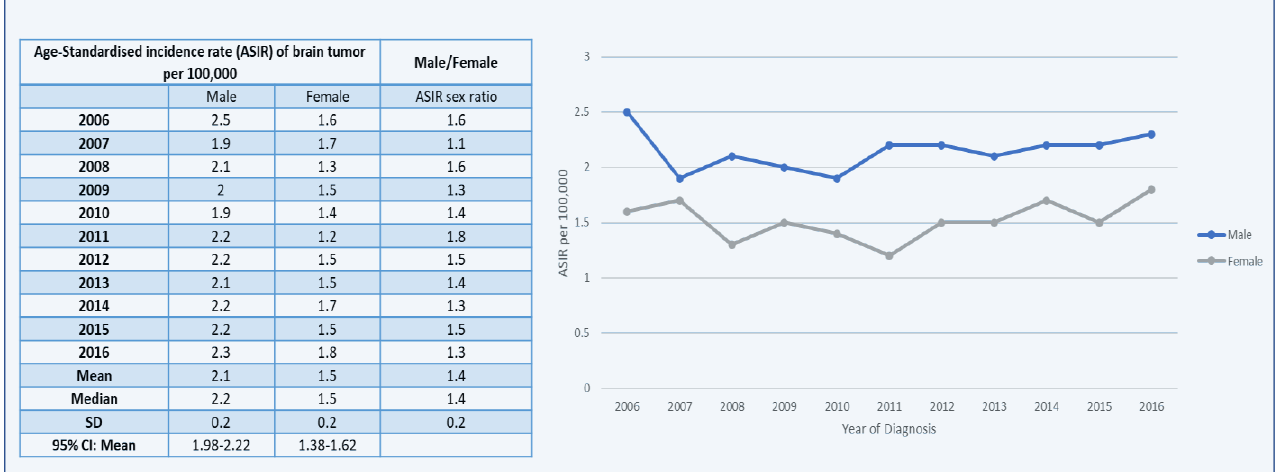
Figure 5. Age-standardized incidence rates (ASIRs) of brain tumor cases per 100,000 between males and females from 2006 to 2016.